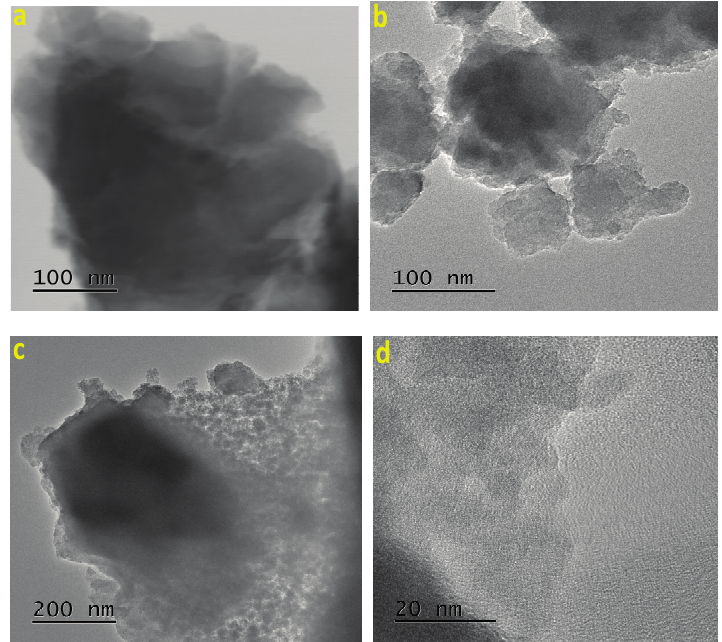
Figure 6. TEM images of the sample containing the CoTSPc species trapped inside the pores of: ( a ) ZrO 2 ( a , b ) TiO 2 networks. TEM images of TiO 2 substrates containing trapped ( c ) NiTSPc ( c or d ) CuTSPc